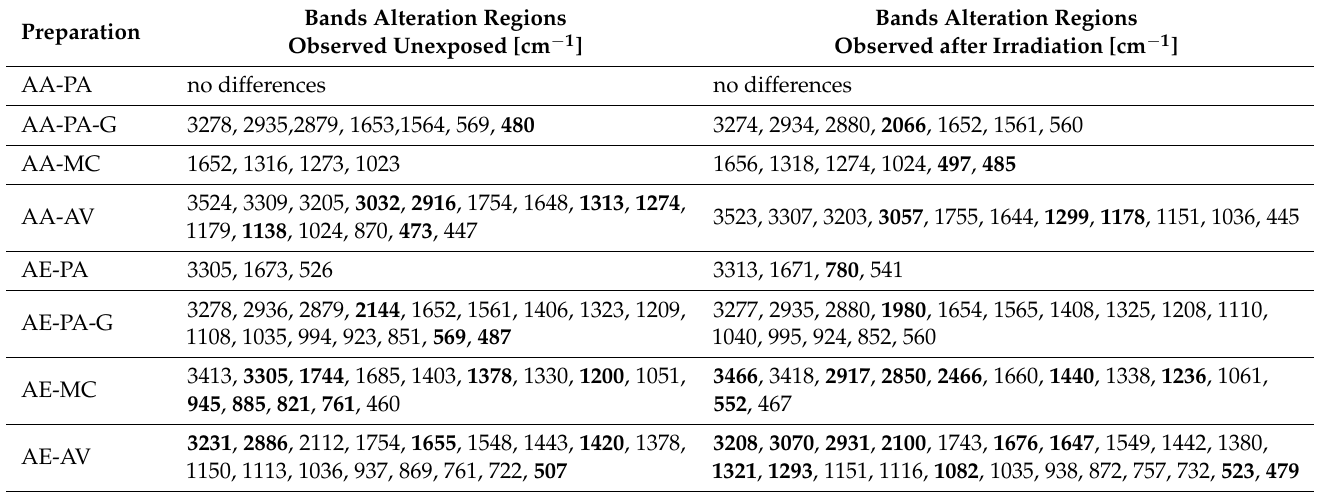
Table 3. The specific and altered signals of